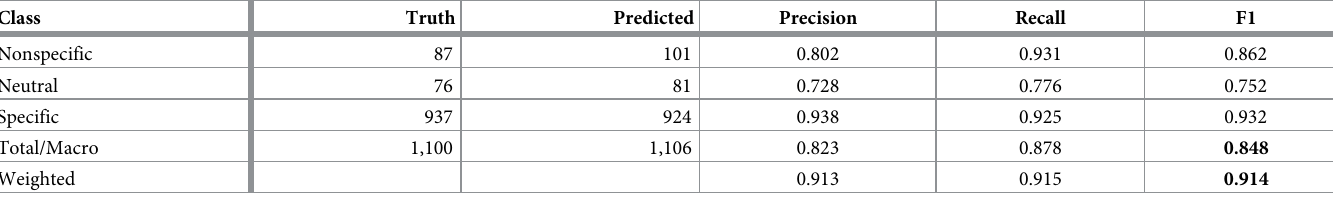
Table 5. Complete workflow